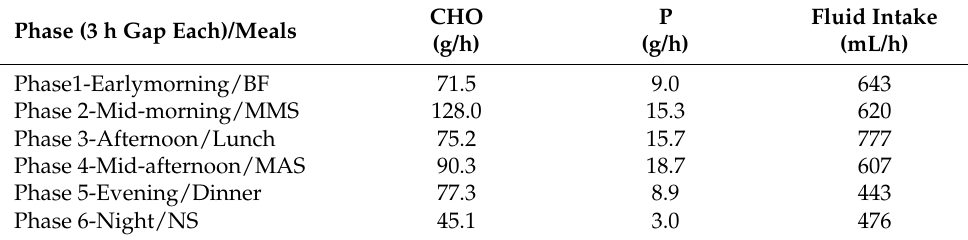
Table 7. Average intake per hour during the event’s six stages.